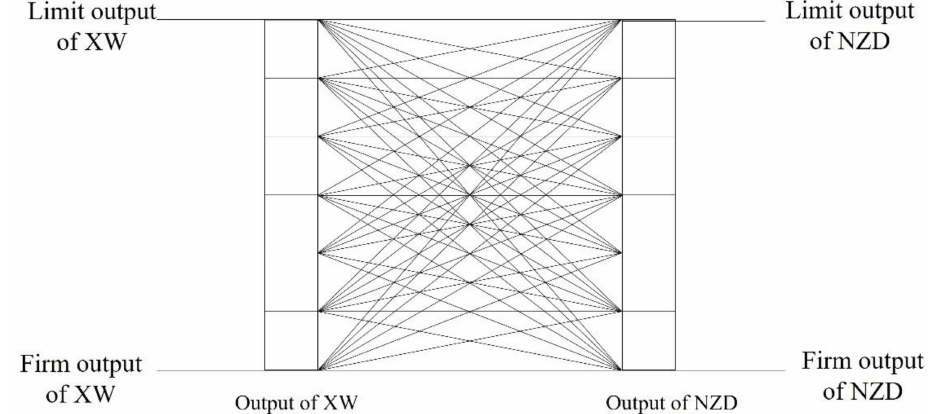
Figure 3. The discrete combinations of the output constraints in water supplement period.